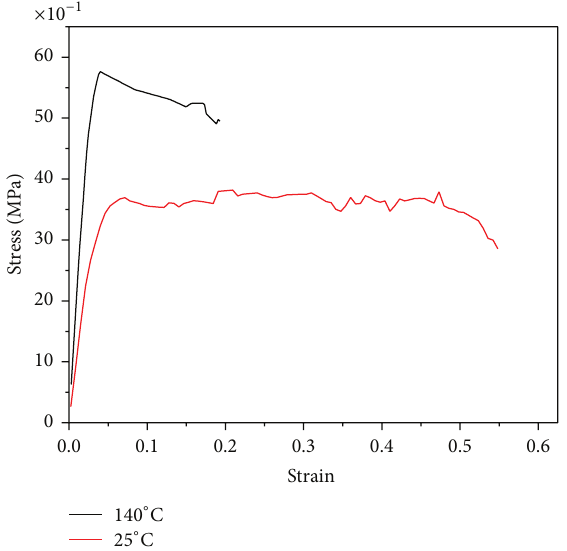
Figure5:TypicalrepresentativestressstraincurvesforPVAsamples heat-treated at two different temperatures and tested at constant speed of 5